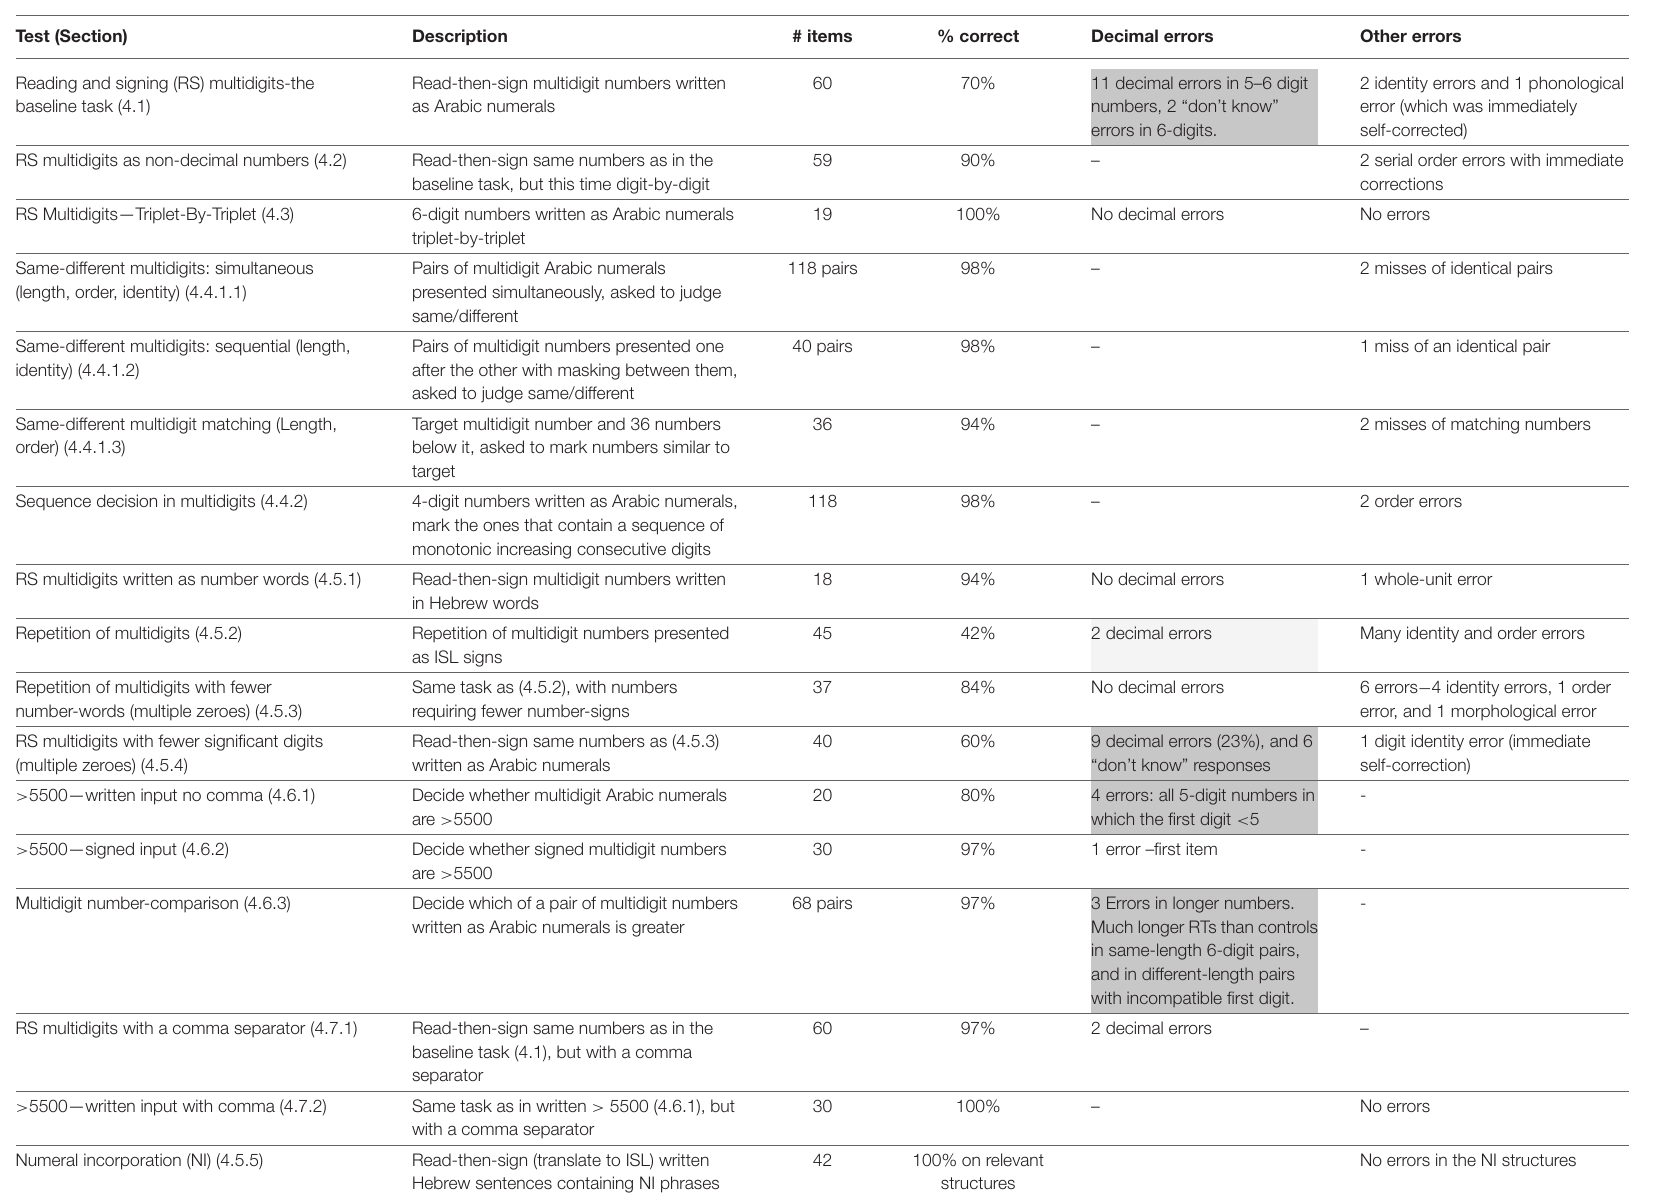
TABLE 1 | The number tests and Nomi’s performance in